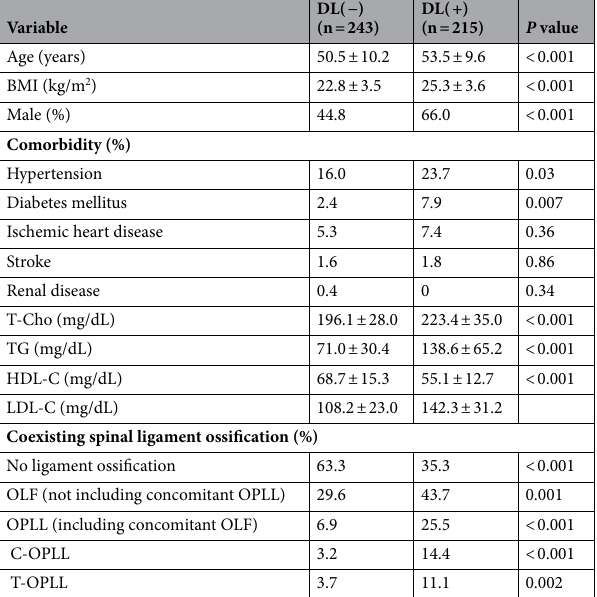
Type of ossification Independent variables β Standardized β 95%